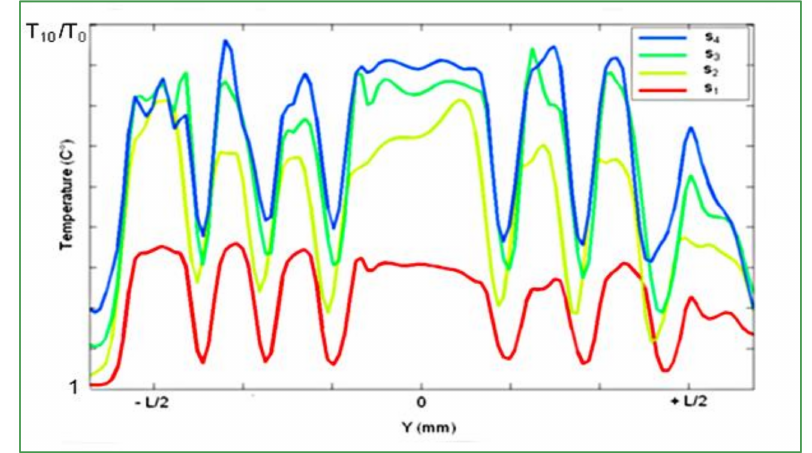
Figure 8. Temperature variation of tire tread for a constant loading of 200 kN, at a given skidding angle of 8 ◦ and for four different velocities: s 1 , s 2 = 3 × s 1 , s 3 = 1.6 × s 2 , s 4 = 1.4 × s 3 .